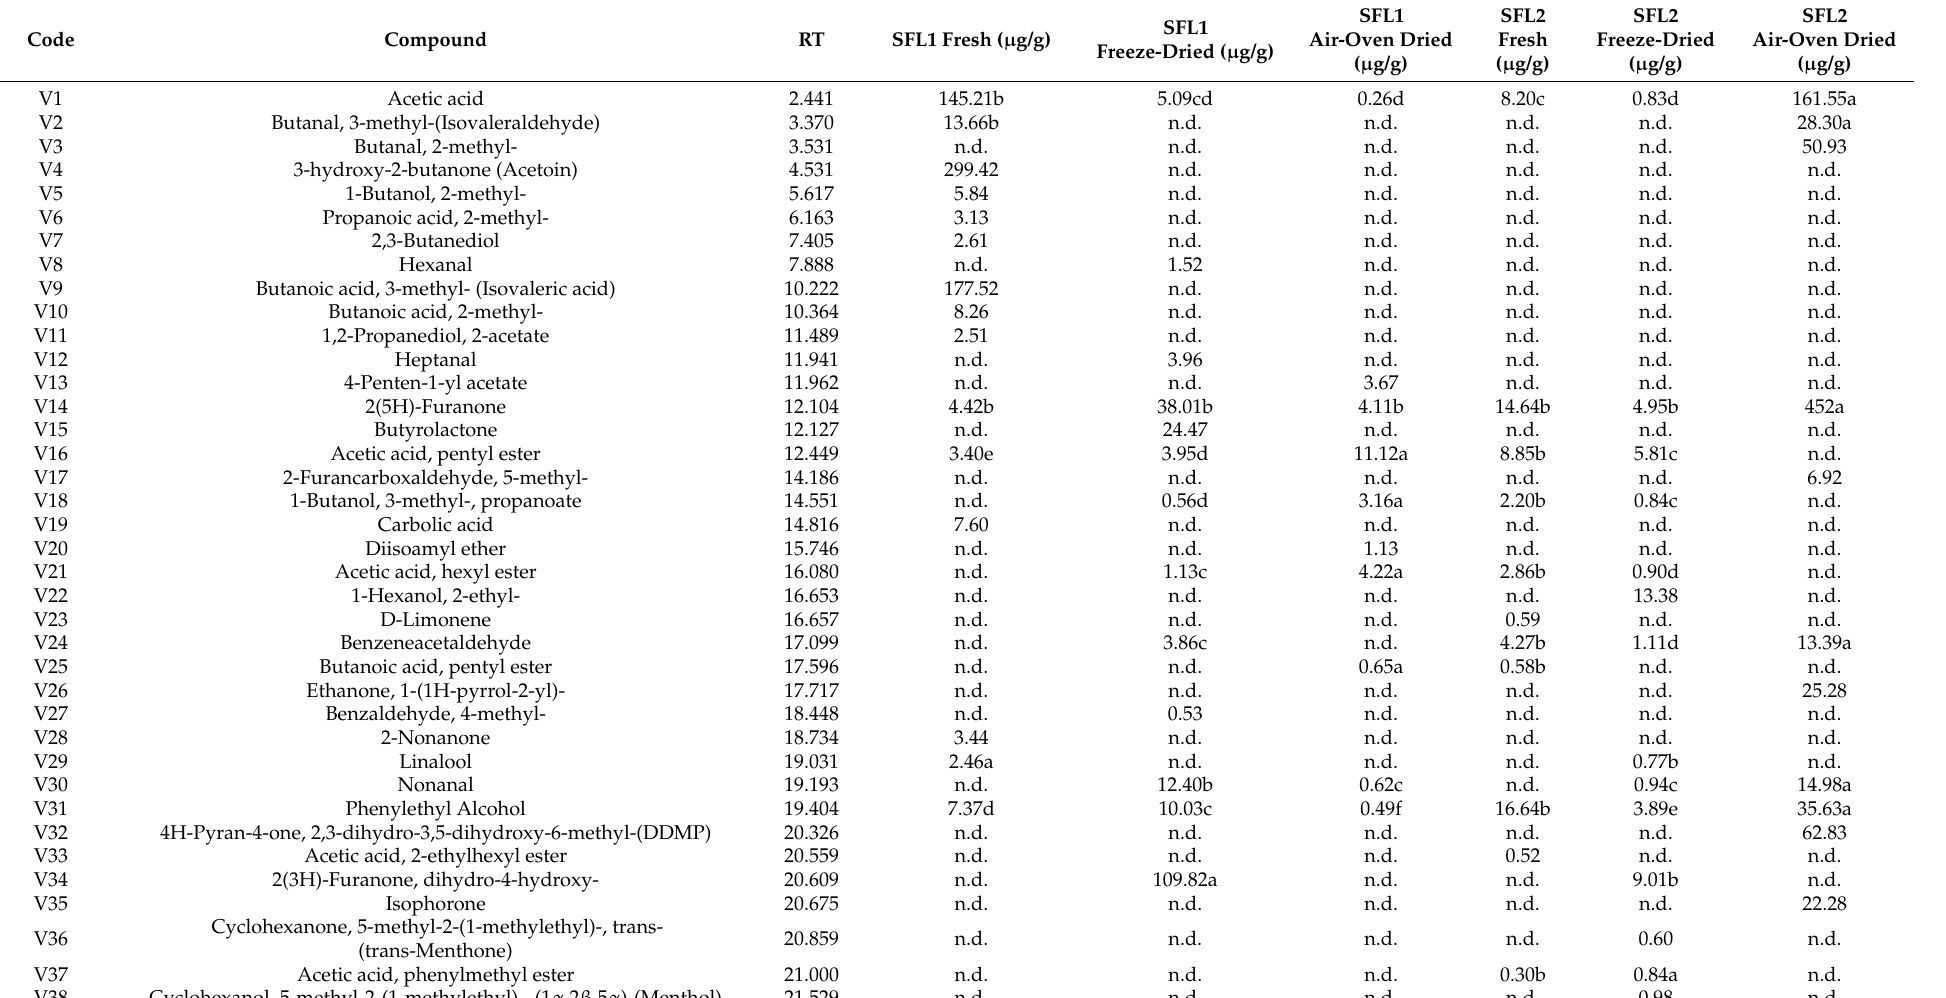
Table 5. Identification and concentration ( µ g/g) of volatile compounds found in saffron floral by-products 1